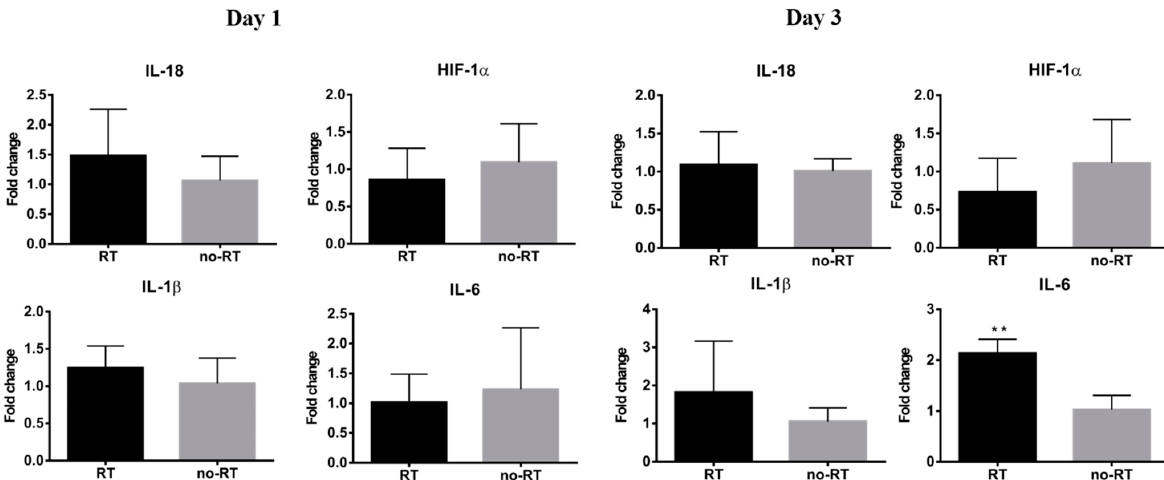
Figure 3. Expression levels of genes encoding for pro-inflammatory cytokines in the RT ( n ≥ 3) and no-RT ( n ≥ 3) groups on the first and third post-irradiation days (right lobe of the liver). On the third post-irradiation day, the expression levels of the IL-6 gene (expressed as fold-change) were significantly increased in the RT group—but not in the no-RT group. ** p <